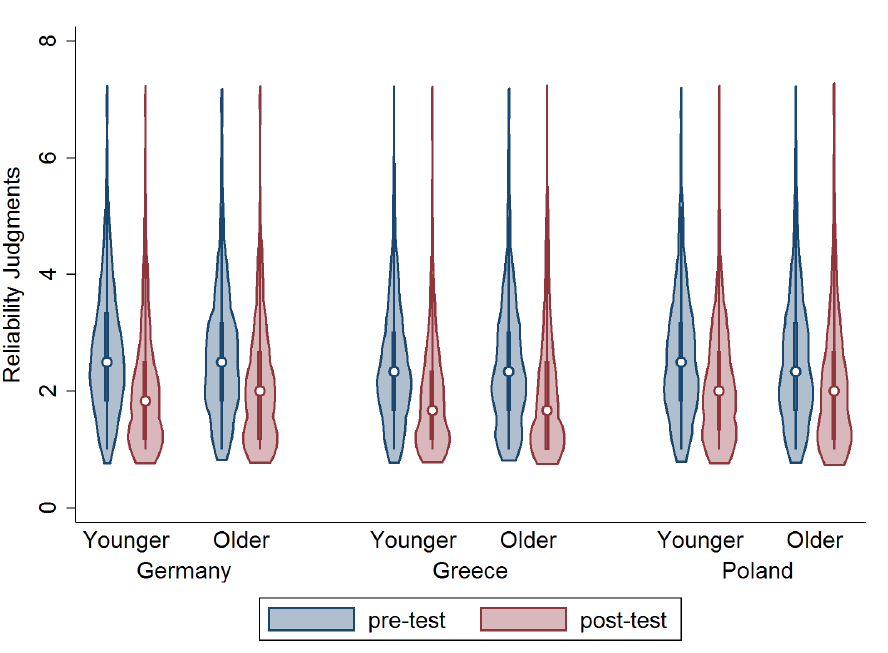
Figure 3. Violin plots for the German, Greek, and Polish versions of the game (pre-and-post-test), by age (Younger = 18-29, Older = 30-49 & over 50 combined). The violin shape represents the distribution of the data and the point estimate is the median (with boxplot). All pre-post differences within each country (by age) are statistically significant at the p < 0.01 level with the exception for older people in Poland ( p =